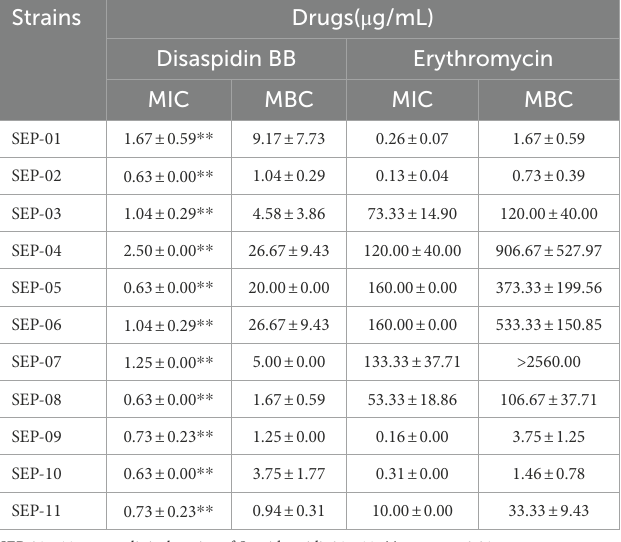
TABLE 2 The MIC and MBC results of Disaspidin BB on Staphylococcus epidermidis.